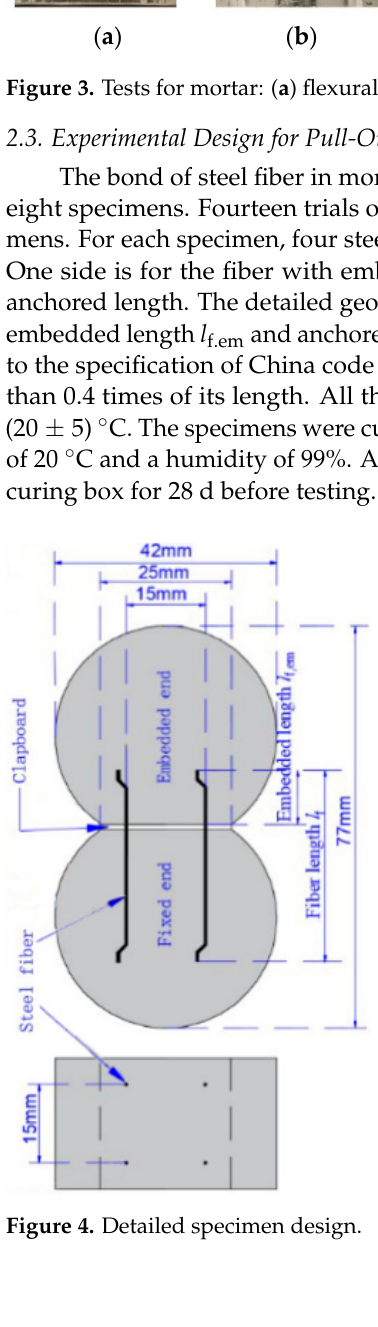
Figure 3. Tests for mortar: ( a ) flexural strength; ( b ) compressive strength.